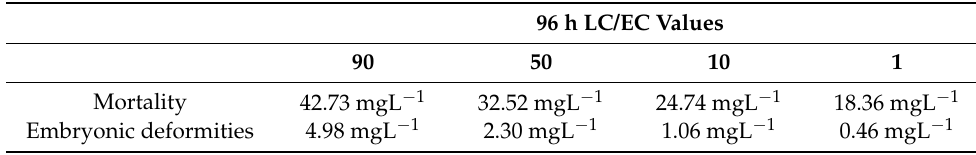
Table 1. Lethal concentration (LC) values for mortality and effective concentration (EC) values for embryonic deformities (tail malformations, reduced body length) induced by bendiocarb on zebrafish embryos exposed to various concentrations. Values are given in milligram per liter at 96 h post-fertilization for